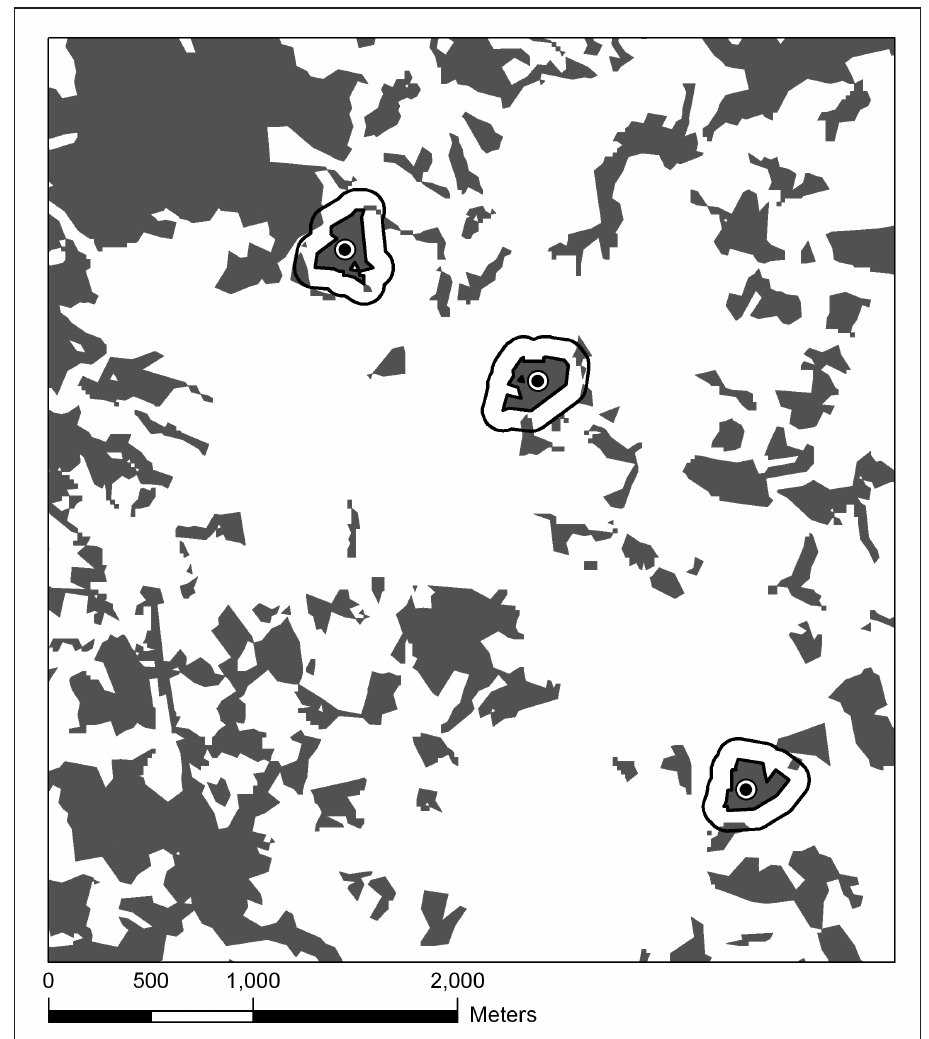
Figure 1. Map of the study area. Circles around the patches represent buffers of 100 m to assess the level of isolation in terms of forest patches within a reachable distance (see Table 1). Patches are from north to south “connected”, “isolated 1” and “isolated